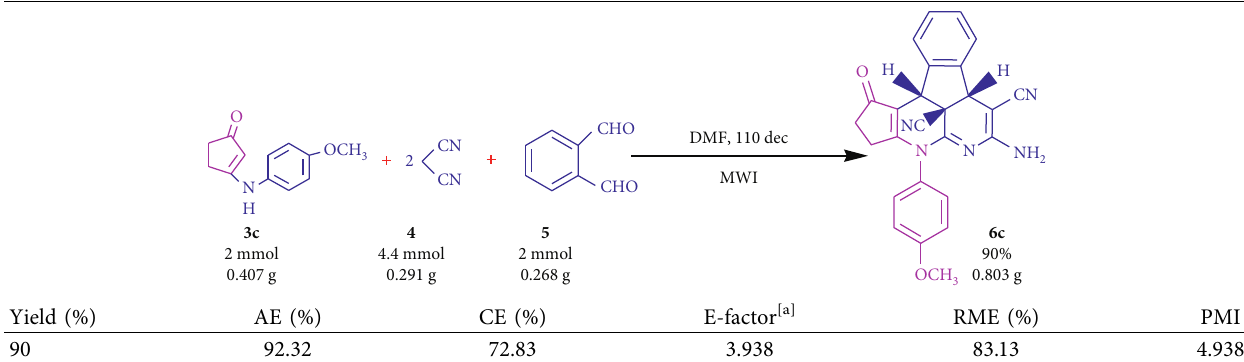
Table 3: Calculated green metrics for the scaled-up synthesis of 6-amino-4-(4-methoxyphenyl)-1-oxo-1, 2, 3, 4, 7a,